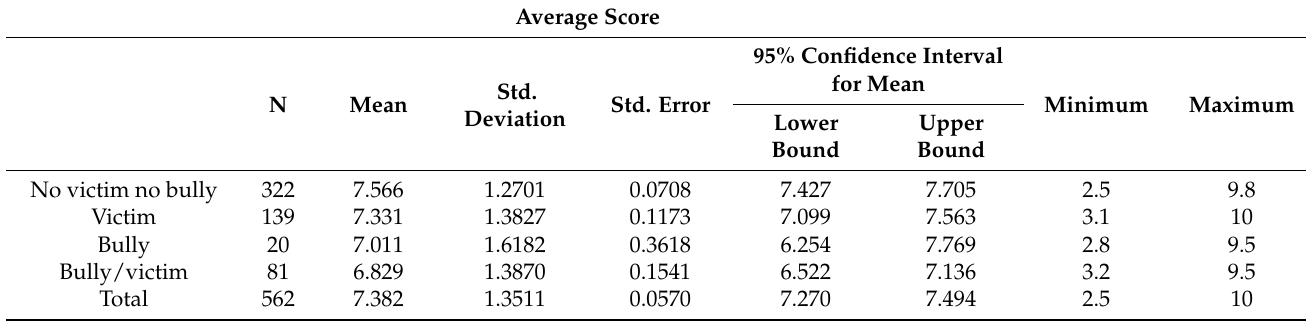
Table 3. Descriptive statistics of the comparison of bullying categories with academic